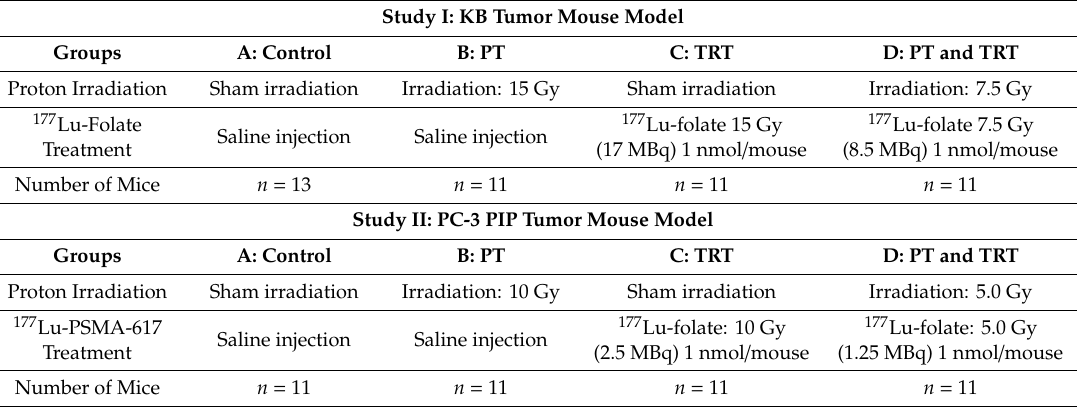
Table 1. Study designs of the therapies using PT and TRT through use of 177 Lu-folate (Study I) or 177 Lu-PSMA-617 (Study